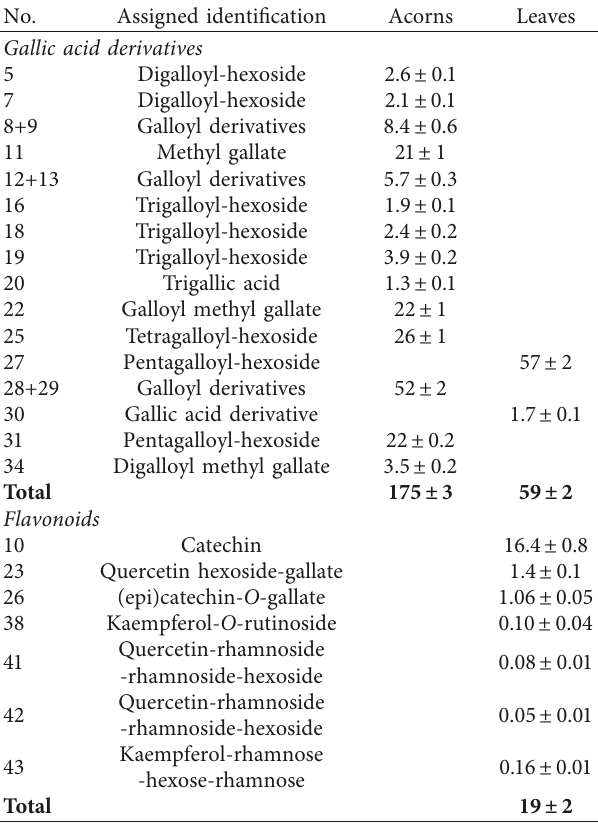
Table 2: Quantification of compounds in extracts of Q. coccifera . Results are expressed in mg/g DE.